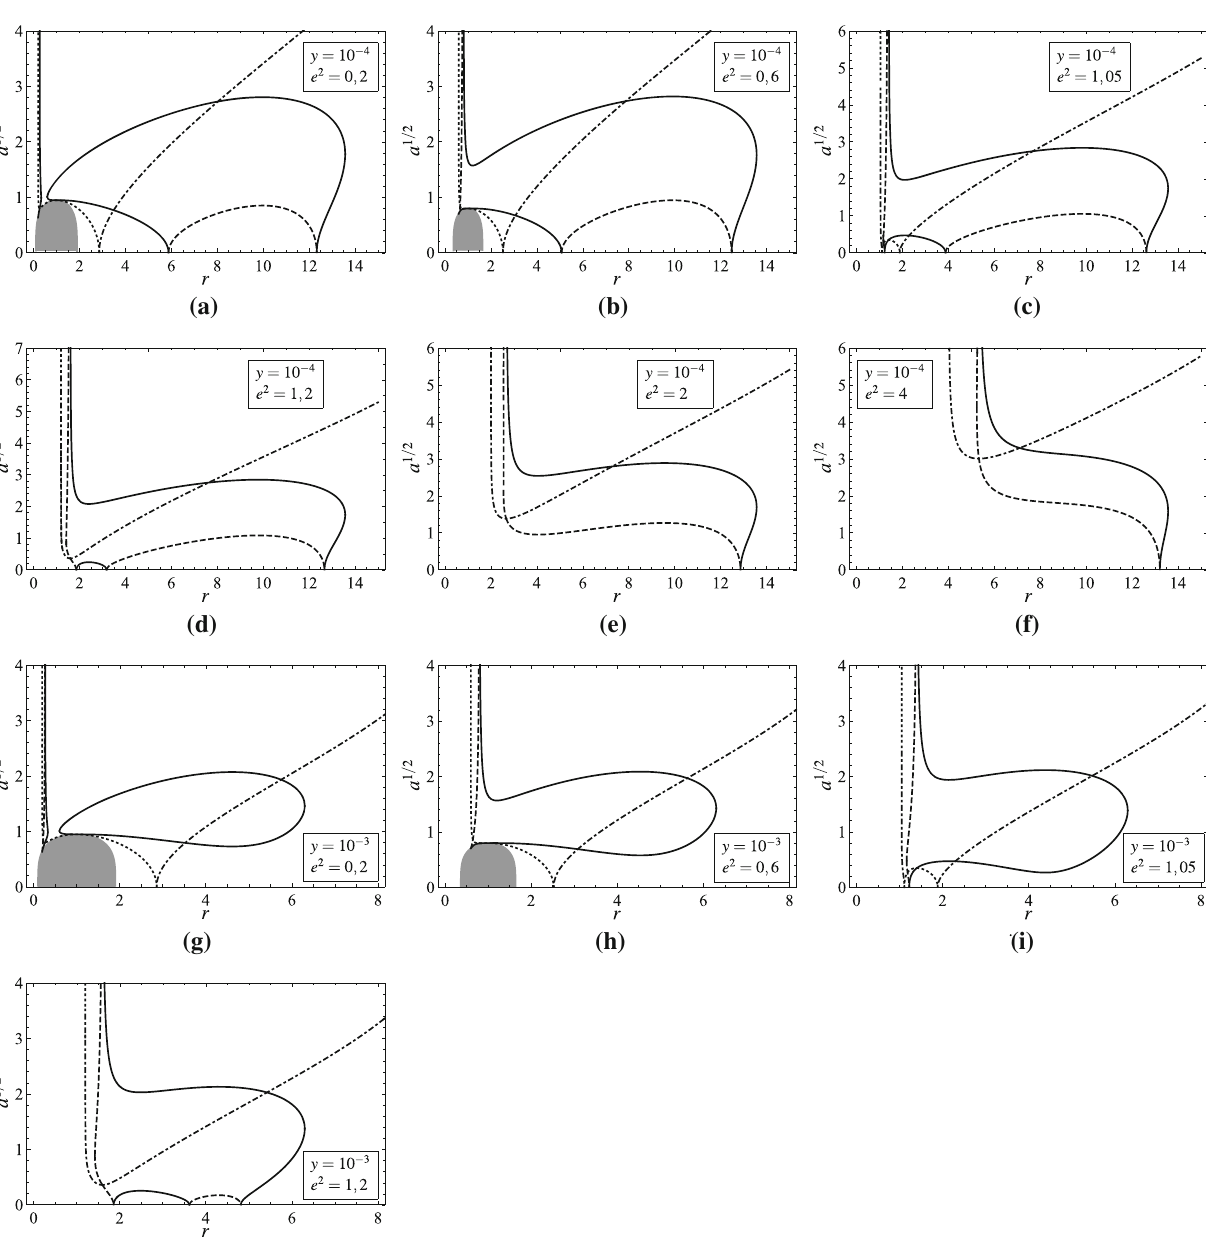
solid/dashed curves, while the plus/minus-family photon orbits are determined by dotted/dashed-dotted curves. Shaded are the regions in between the inner and outer black-hole horizons, if they exist